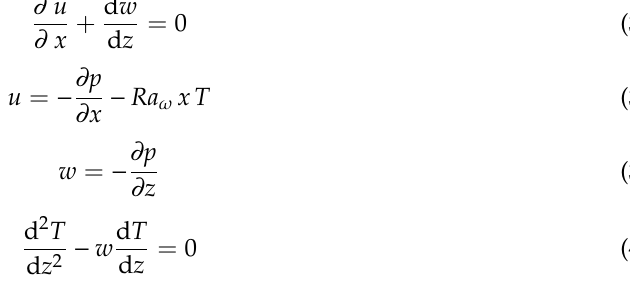
insulated on its sidewalls. (Reprinted from [37], with permission from Elsevier Science Ltd.)